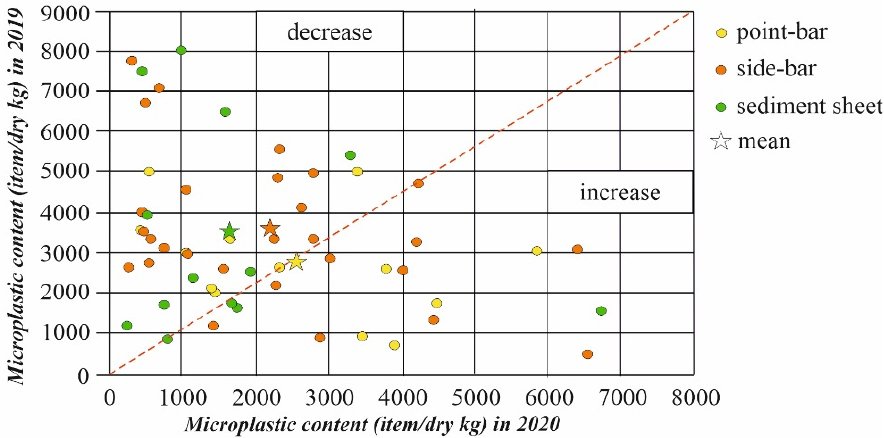
Figure 10. Microplastic content (item/dry kg) of coarse sediments collected on various geomorpho- logical forms in 2019 and 2020.